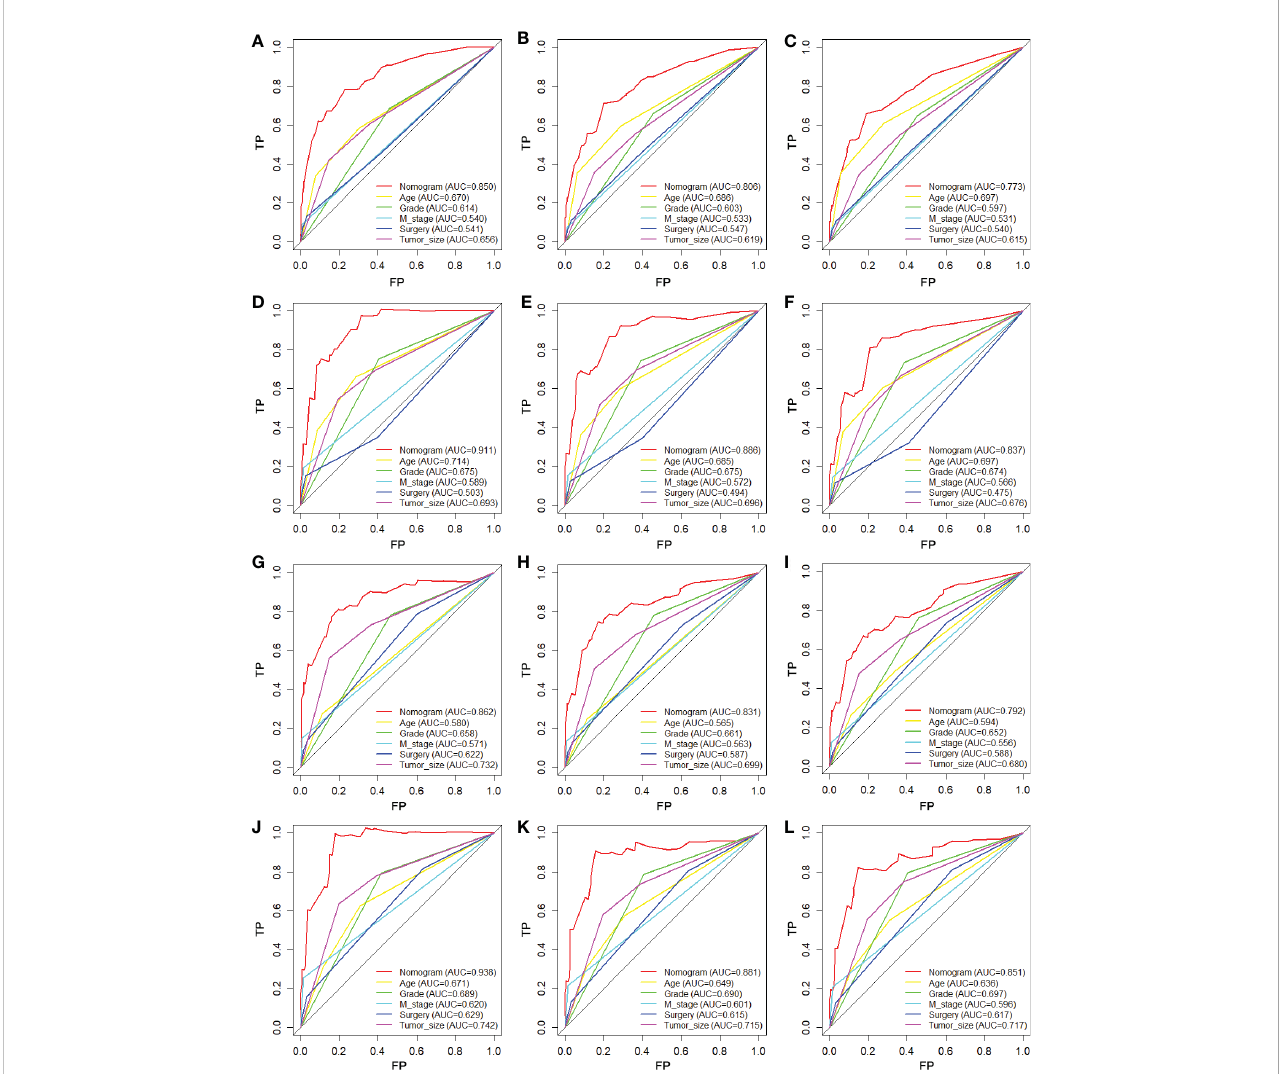
FIGURE 5 Comparison of ROC curves between the nomogram and independent predictors at 24 (A) , 36 (B) , and 48 months (C) in the training cohort and at 24 (D) , 36 (E) , and 48 months (F) in the veri fi cation cohort for OS analysis and at 24 (G) , 36 (H) , and 48 months (I) in the training cohort and at 24 (J) , 36 (K) , and 48 months (L) in the veri fi cation cohort for CSS